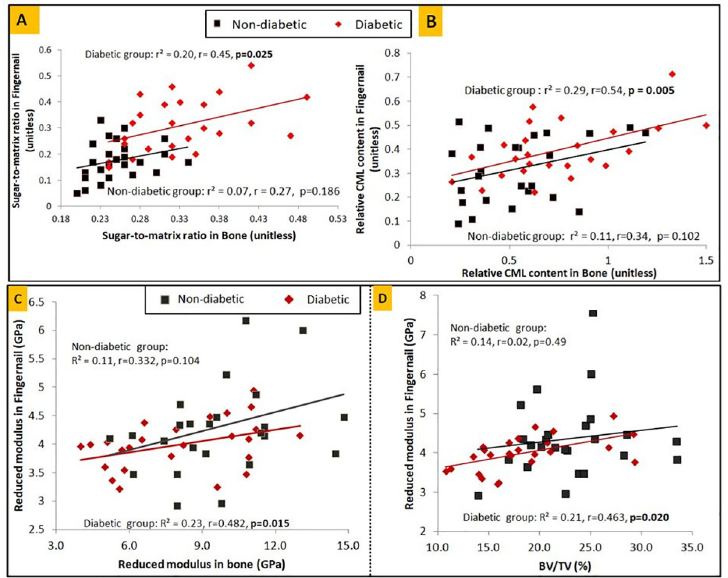
Fig 7. Correlation between fingernail and bone for diabetic patients and non-diabetics (A) for sugar-to-matrix ratio, (B) for relative CML content, (C) for nanoindentation determined reduced modulus, (D) BV/TV of trabecular bone and fingernail reduced